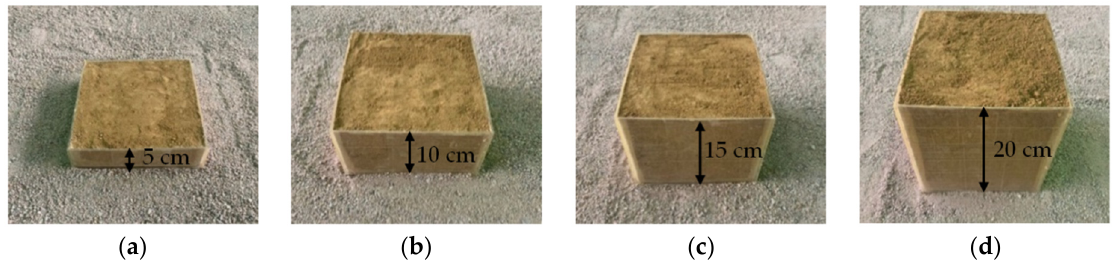
Figure 3. Physical drawings of void fillers with different sizes: ( a ) 5 cm high model box; ( b ) 10 cm high model box; ( c ) 15 cm high model box; ( d ) 20 cm high model box. high model box; ( c ) 15 cm high model box; ( d ) 20 cm high model